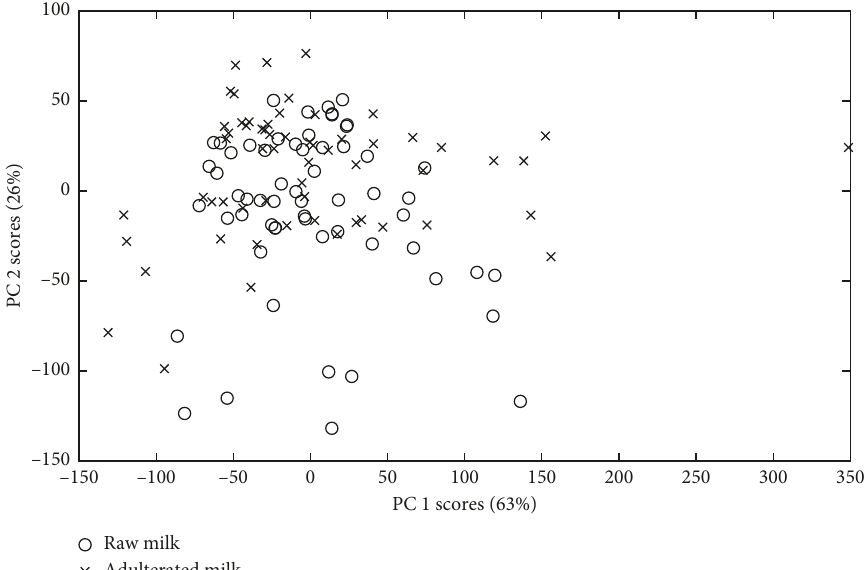
Figure 3: Principal component analysis scores plots of FTIR fingerprints.